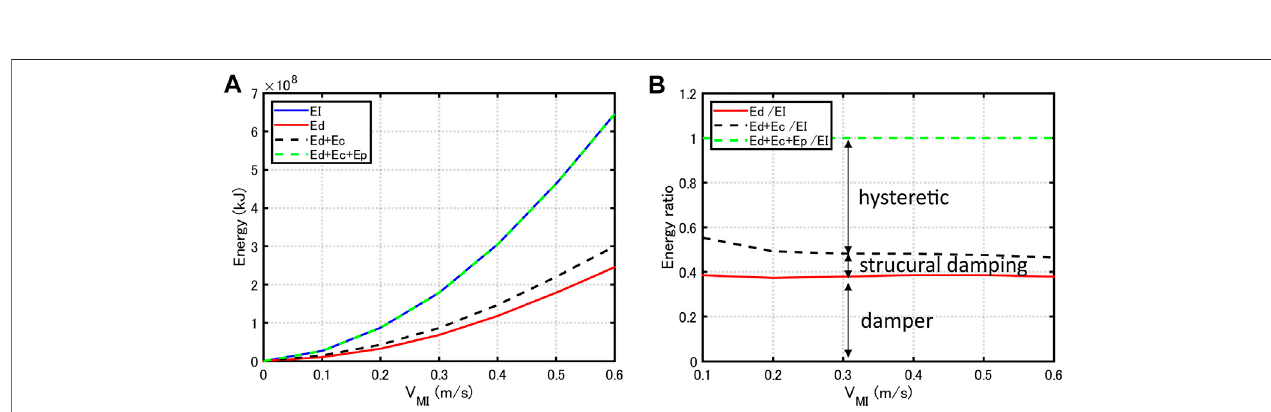
FIGURE 9 | Energy responses to input level of resonant equivalent sine waves, (A) Energy response, (B) Energy ratio.